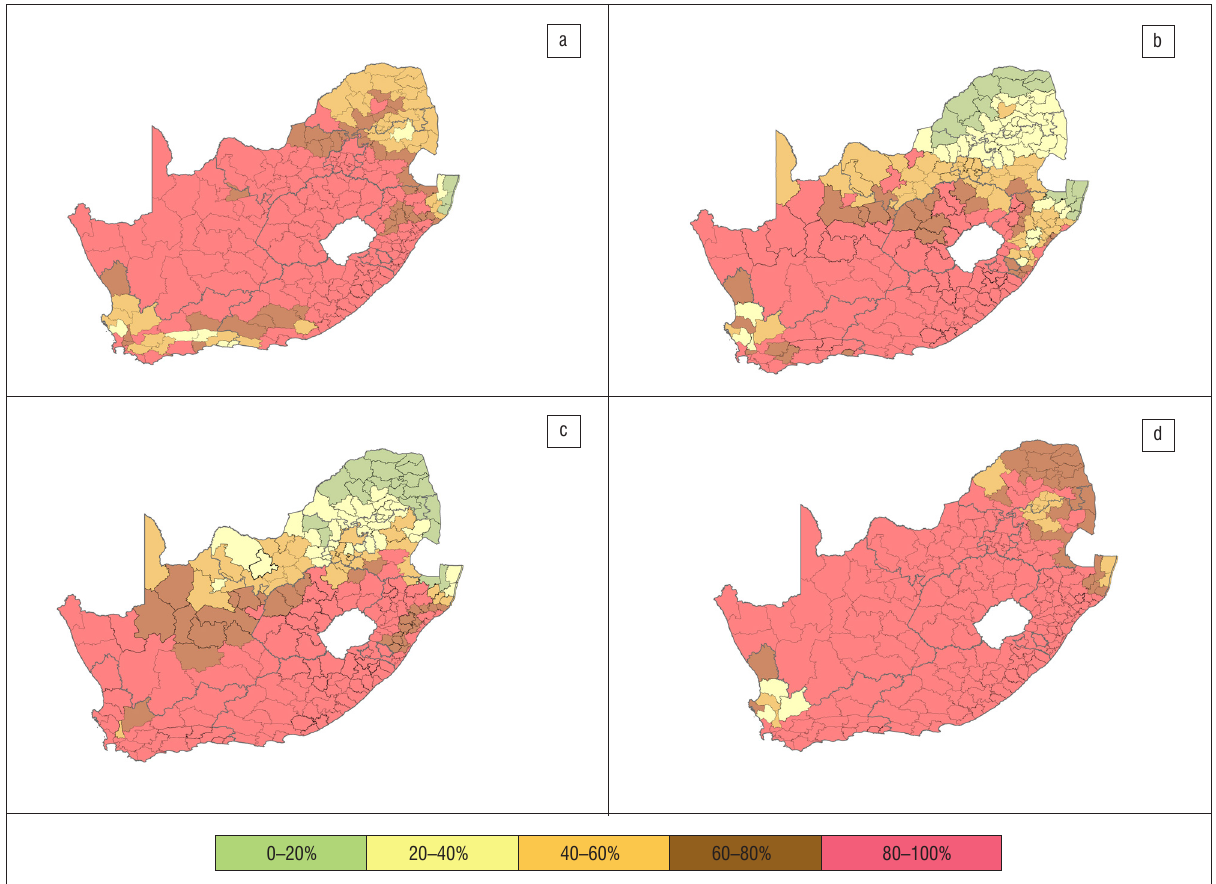
Figure 3: Likelihood of a wind hazard, defined by the probability of occurrence of a gust equal to or greater than 20 m/s, per season: (a) Summer (DJF), (b) autumn (MAM), winter (JJA) and (d) spring